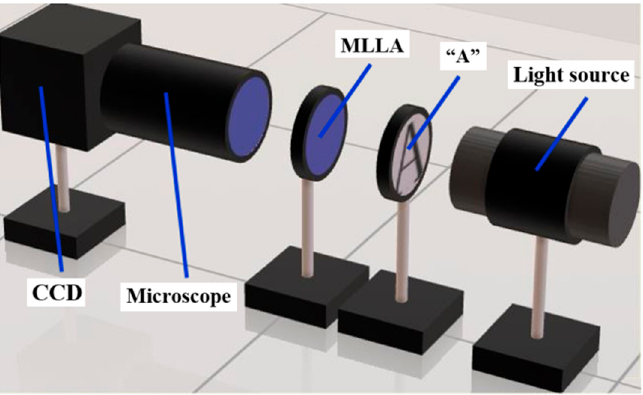
Figure 8. Schematic of the experiment system.